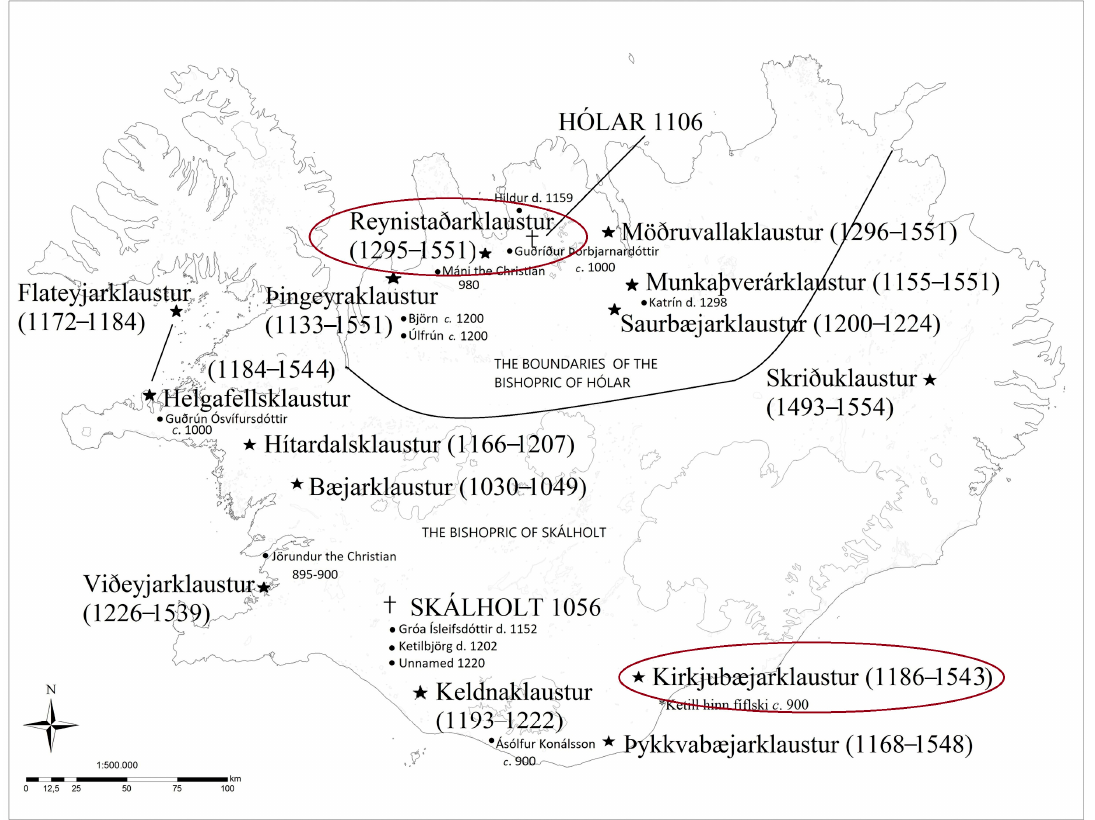
Figure 1. The monastic houses operating in Iceland during medieval times. The red circles indicate the two female houses. The location of the two bishoprics, Skálholt and Hólar, are also shown (Kristj á nsd ó ttir 2023, p. 3).